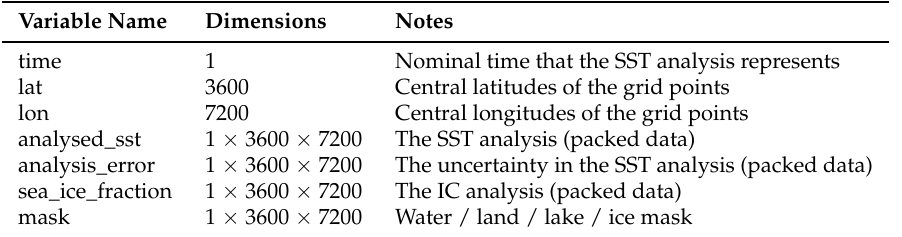
Table 2. Variables contained in the main OSTIA output files. Some of the variables are stored as packed data, which means that they have to be multiplied by their scale_factor attribute and the add_offset attribute added in order to obtain the actual numbers.